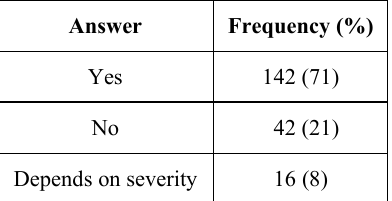
Table 5. The frequency table for Q6 answers.